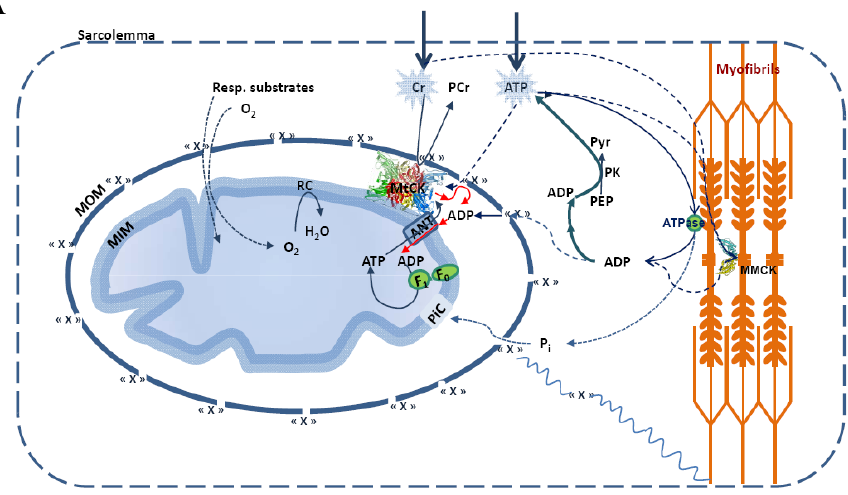
Figure 2. Demonstration of the central role of mitochondrial creatine kinase, MtCK, in regulation of respiration of permeabilized muscle cells. (A) Scheme shows the principles of the method used to study interaction between mitochondrial and glycolytic systems in competition for endogenous ADP. This Scheme shows mitochondrion in situ within intracellular energetic units, ICEUs [93] surrounded by cytoskeleton proteins (depicted as “x” factor) and myofibrils. Exogenous ATP is hydrolyzed by cellular ATPases into endogenous extramitochondrial ADP and inorganic phosphate (Pi). Mitochondrial (MtCK) and non-mitochondrial creatine kinases in myofibrils and at membrane of sarcoplasmic reticulum in the presence of creatine and ATP produce endogenous intra- and extramitochondrial ADP. Phosphoenolpyruvate (PEP) and pyruvate kinase (PK) system removes extramitochondrial ADP produced by intracellular ATP consuming reactions and continuously regenerate extramitochondrial ATP. Endogenous intramitochondrial ADP produced by MtCK forms microcompartments within the mitochondrial intermembrane space (IMS) and is re-imported into the matrix via adenine nucleotide translocase (ANT) due to its functional coupling with MtCK. Reproduced from [29] with permission. (B,C) Oxygraph recording of respiration of permeabilized cardiomyocytes (B) and fibers from human skeletal m. vastus lateralis (C) prepared from biopsy samples of healthy volunteers as described in Figure 1 in the presence of 2 mM malate and 5 mM glutamate as substrates. Addition of 2 mM MgATP activates respiration due to production of endogenous MgADP in ATPase reaction. Pyruvate kinase (PK) in the presence of 5 mM phosphoenolpyruvate (PEP) decreases respiration rate due to removal of extramitochondrial MgADP. Creatine in the presence of MgATP activates mitochondrial creatine kinase (MtCK) reaction of production of endogenous intramitochondrial MgADP which rapidly activates respiration up to the maximal rate (see Figure 1A), that showing that mitochondrial ADP is not accessible for PK-PEP system due to the limited permeability of mitochondrial outer membrane in the cells in situ . Right panels in B and C show confocal images of isolated cardiomyocytes and fibers from m. vastus lateralis, correspondingly. Reproduced from [92] with